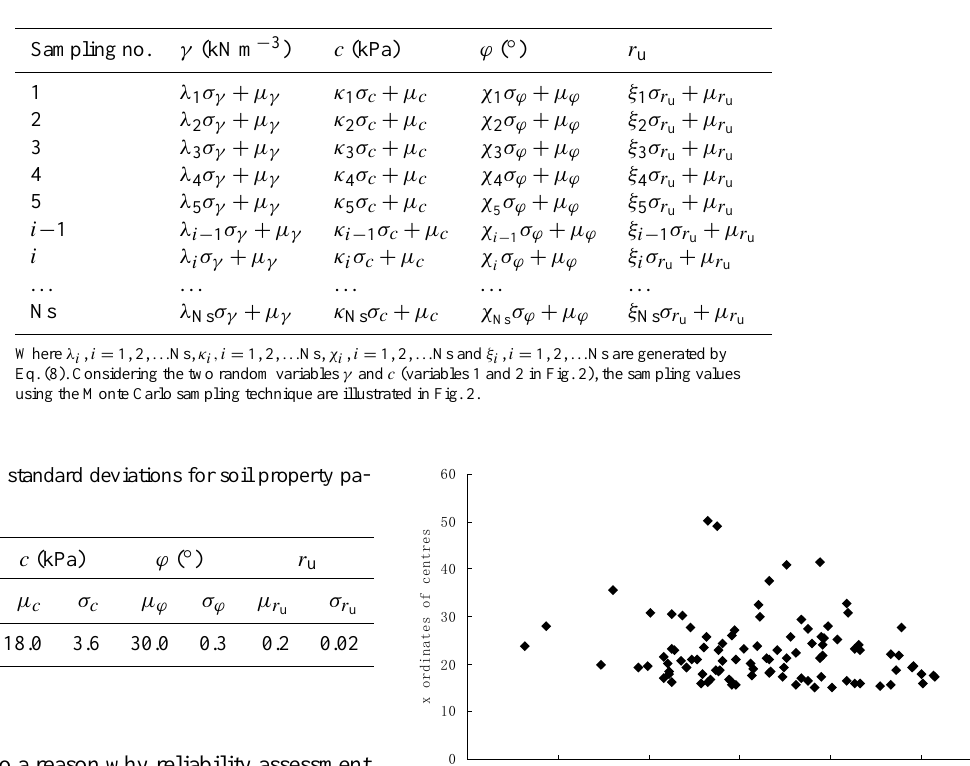
Table 1. Sampling details for example 1.